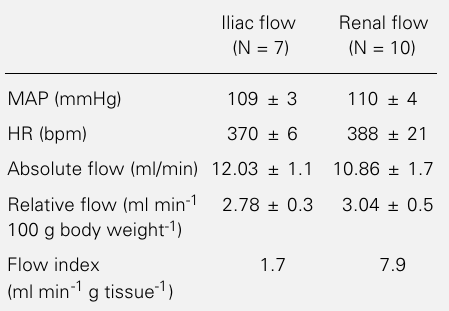
Table 1 - Resting mean arterial pressure (MAP), heart rate (HR), and iliac and renal flow measured with a 1-mm probe in 2 groups of